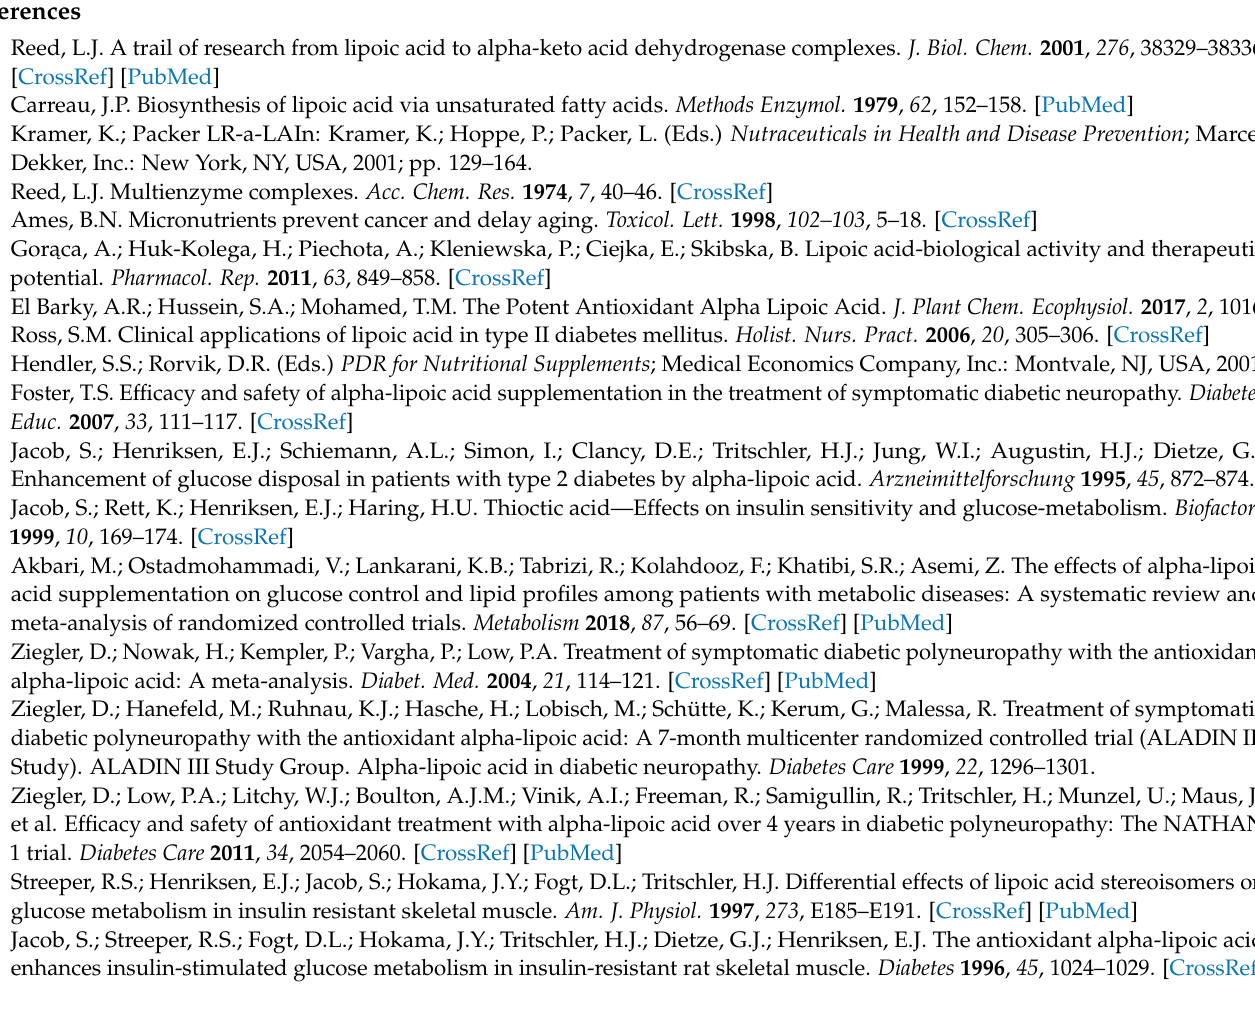
Figure A3. Mean a-LA concentration in ppm in the different Foods analyzed by High-Pressure Liquid Chromatography Control, Food 1, Food 2 and Food 3 have 0 ppm, 75 ppm, 150 ppm and 300 ppm of a-LA respectively.